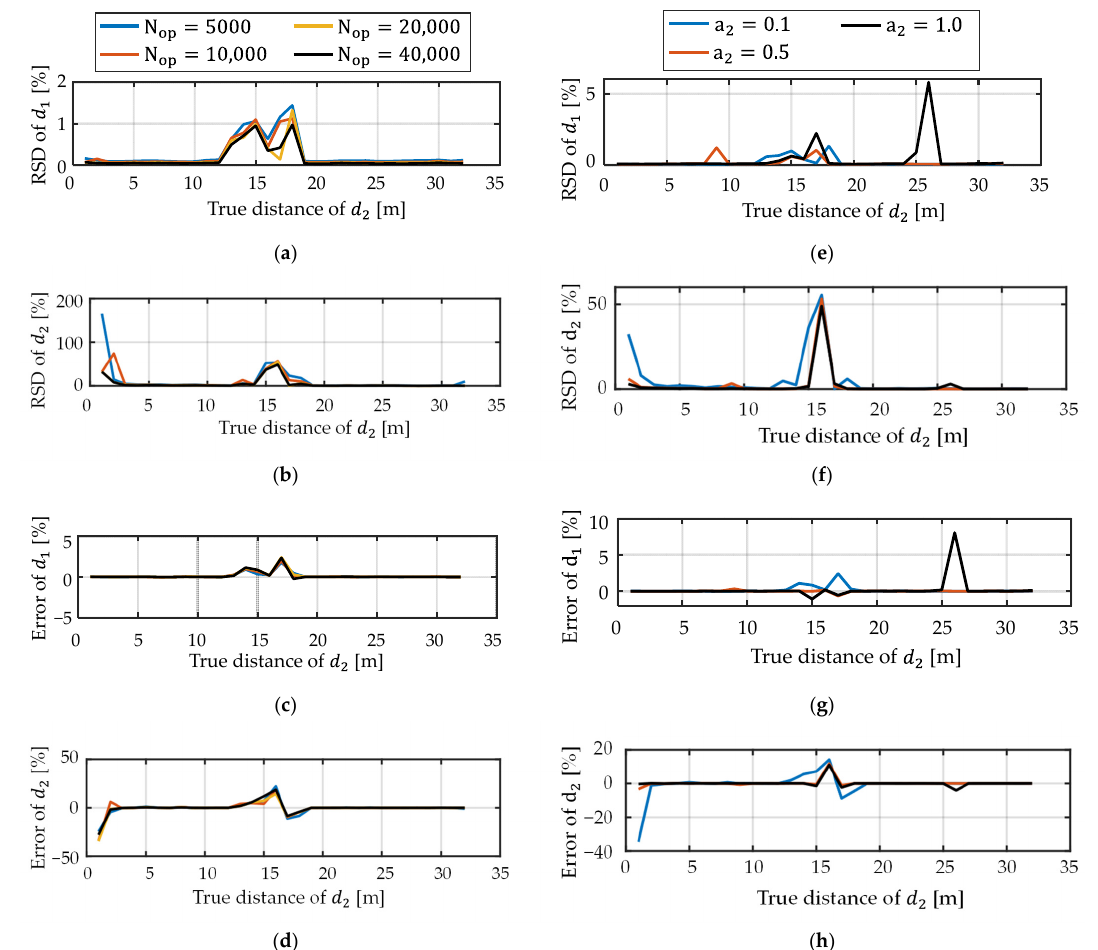
Figure 9. Results of dual-path simulations: ( a – d ) Type A. N op was changed. ( e – h ) Type B. a 2 was changed. ( a , e ) Relative standard deviation of d 1 . ( b , f ) Relative standard deviation of d 2 . ( c , g ) Relative mean error of d 1 . ( d , h ) Relative mean error of d 2 .